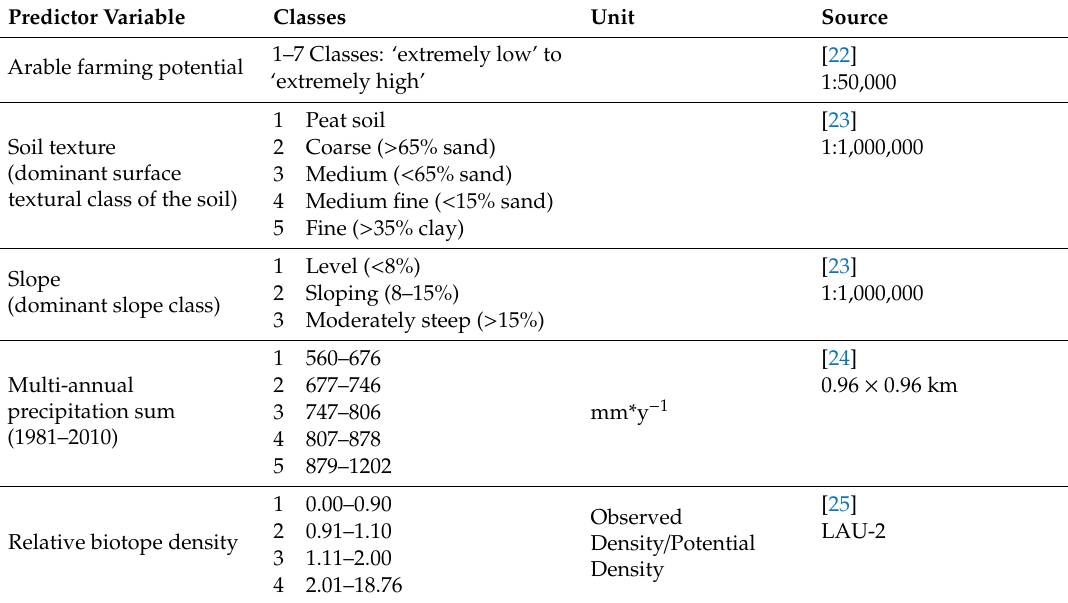
Table 1. Site variables with their classes, units, and source scale. Classification of the metric variables was implemented corresponding to the geometrical